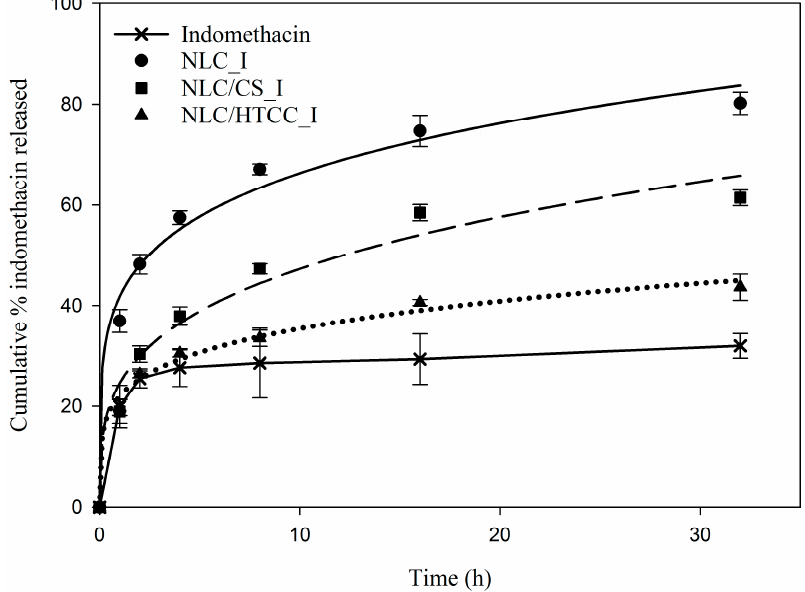
Figure 6. In vitro release profiles of three different indomethacin loaded NLC formulations. NLC_I, indomethacin loaded NLC formulation; NLC/CS_I: indomethacin loaded NLC formulation coated with chitosan; NLC/HTCC_I, indomethacin loaded NLC formulation coated with HTCC. Each formulation was fitted according to Korsmeyer-Peppas regression model except pure indomethacin.